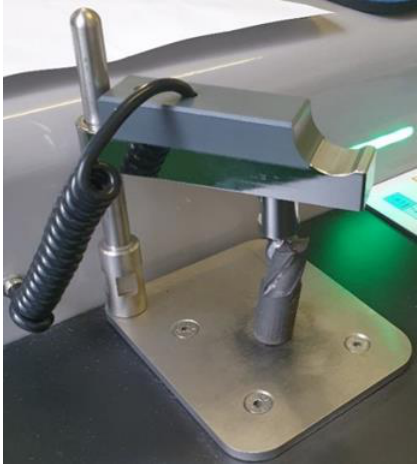
Figure 4. Chemical composition analysis of the printed tool.